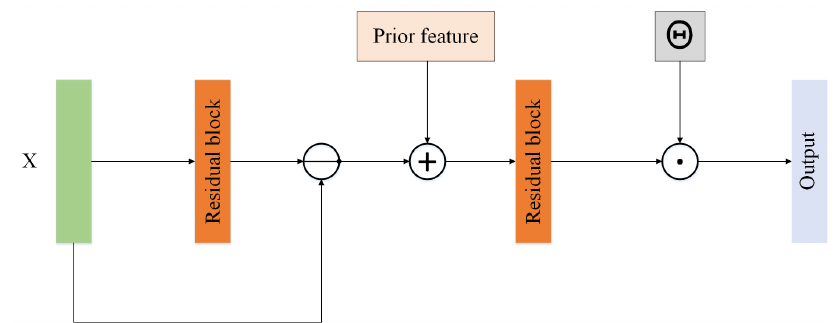
Figure 3. The structure of gradient